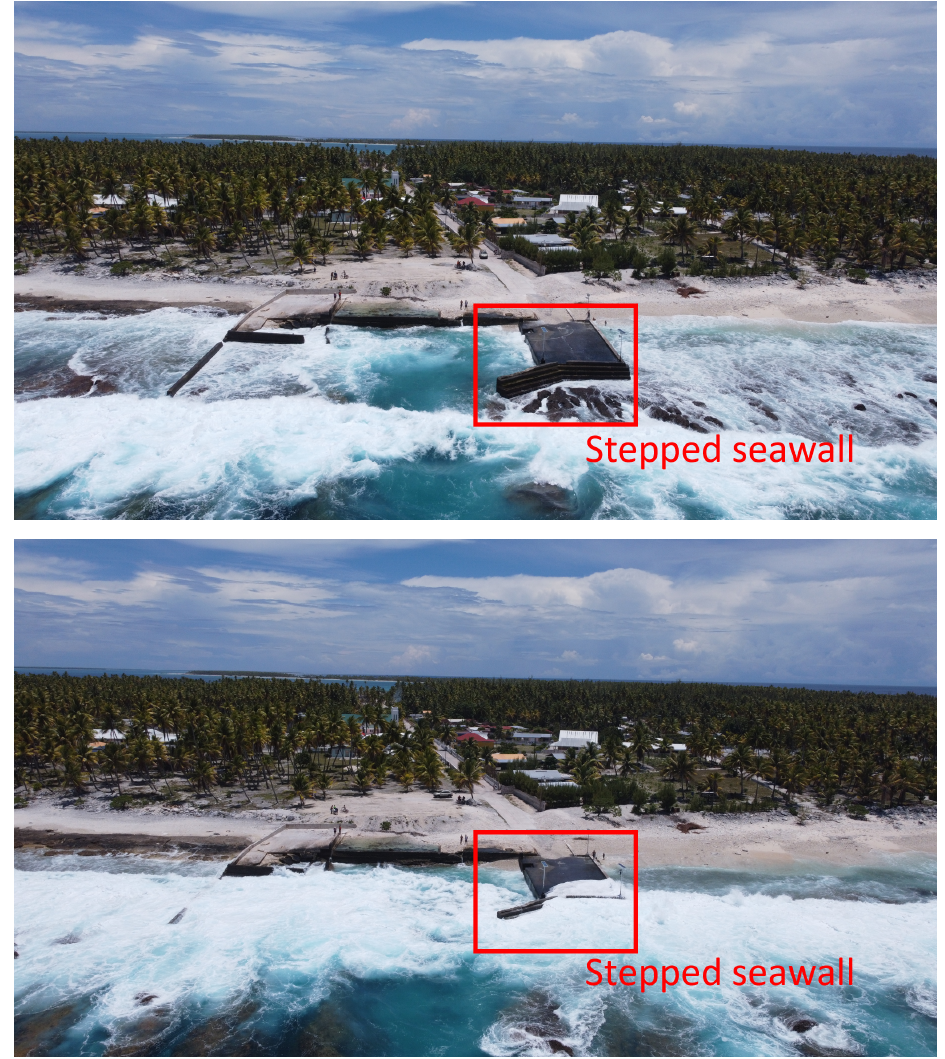
Figure 1. Channel-basin system in the Reao fringing reef French Polynesia— Courtesy of A.Para, ODEWA